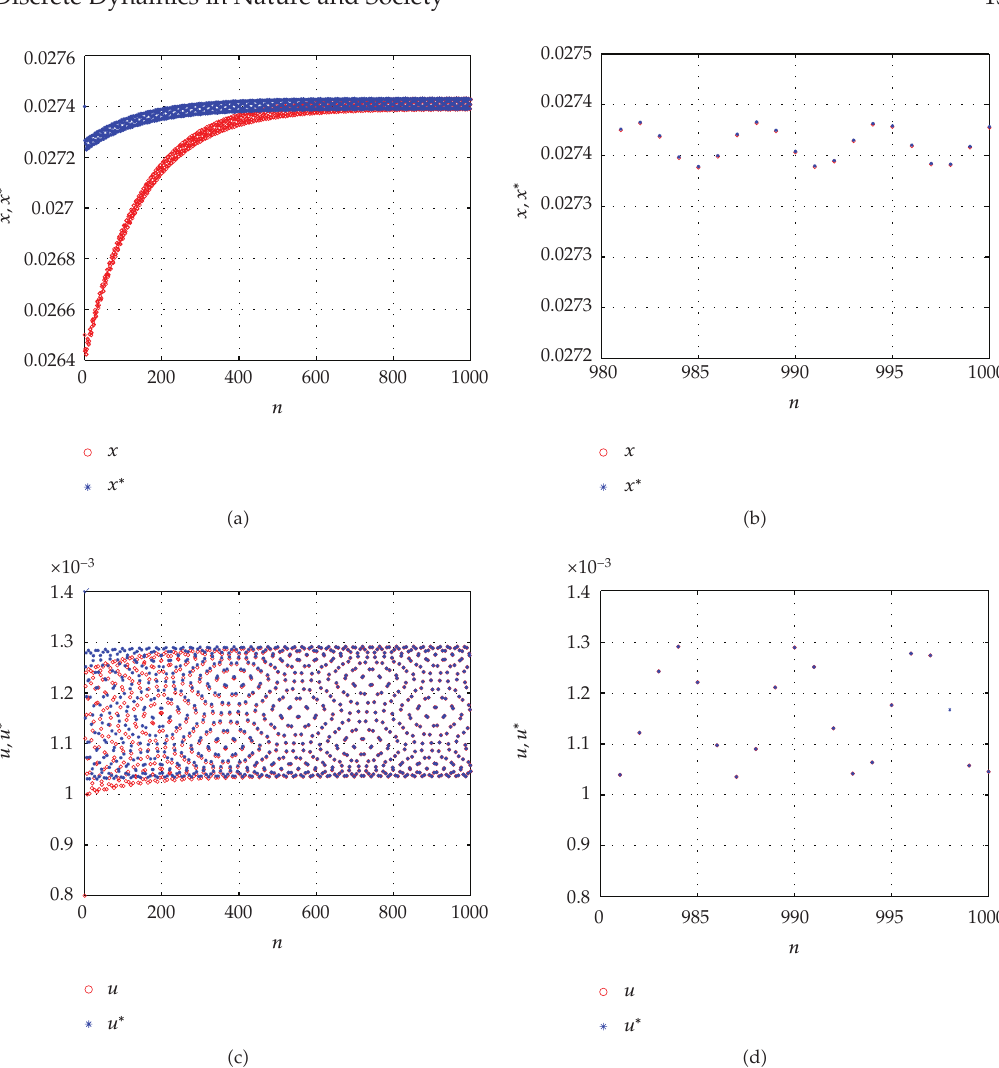
Figure 2: Global attractivity of system (cid:5) 4.1 (cid:6) with di ff erent initial values. x with x (cid:5) − 1 (cid:6) (cid:7) 0 . 04, { x (cid:5) 0 (cid:6) ,u (cid:5) 0 (cid:6) } (cid:7) { 0 . 0265 , 0 . 0008 } and x ∗ with x ∗ (cid:5) − 1 (cid:6) (cid:7) 0 . 05, { x ∗ (cid:5) 0 (cid:6) ,u ∗ (cid:5) 0 (cid:6) } (cid:7) { 0 . 0274 , 0 . 0014 } . (cid:5) a (cid:6) and (cid:5) b (cid:6) show (cid:5) x,x ∗ (cid:6)